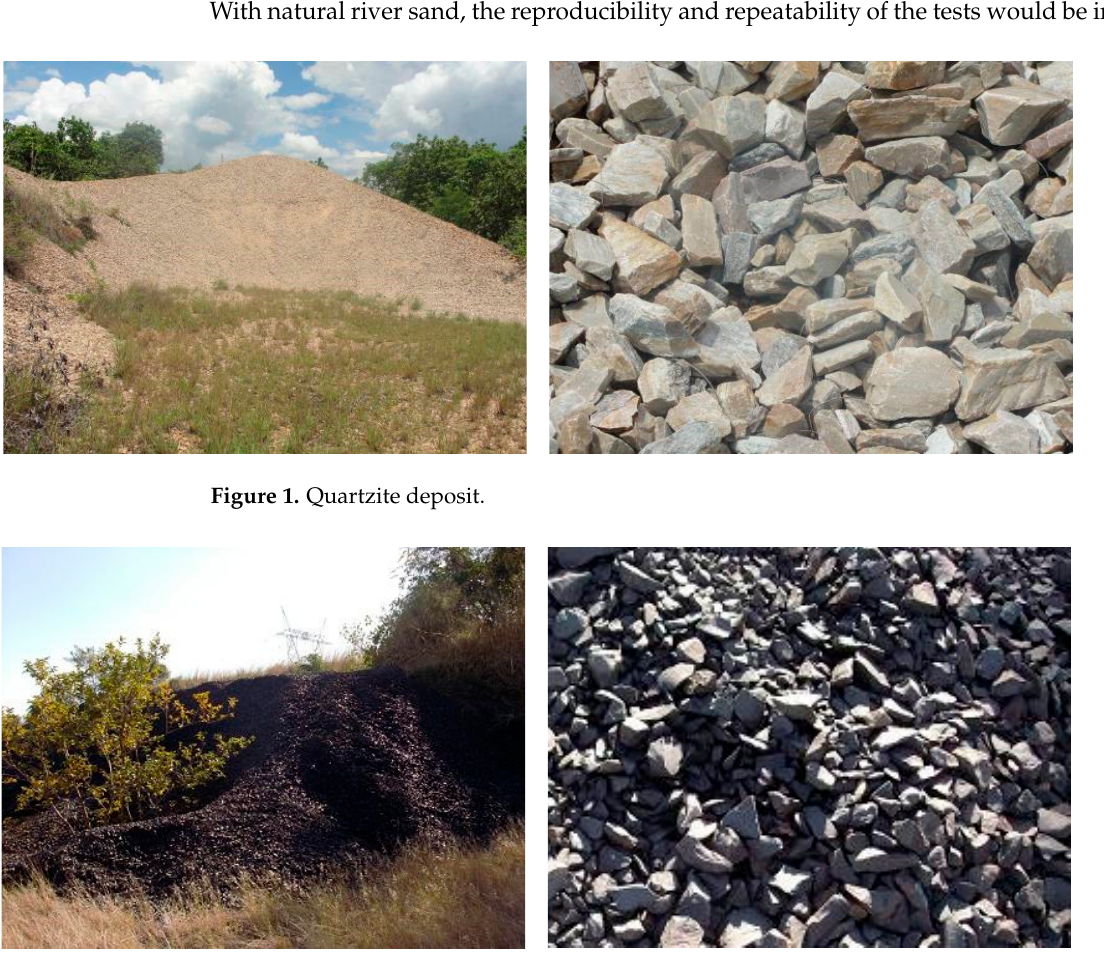
Figure 2. Basalt deposit.